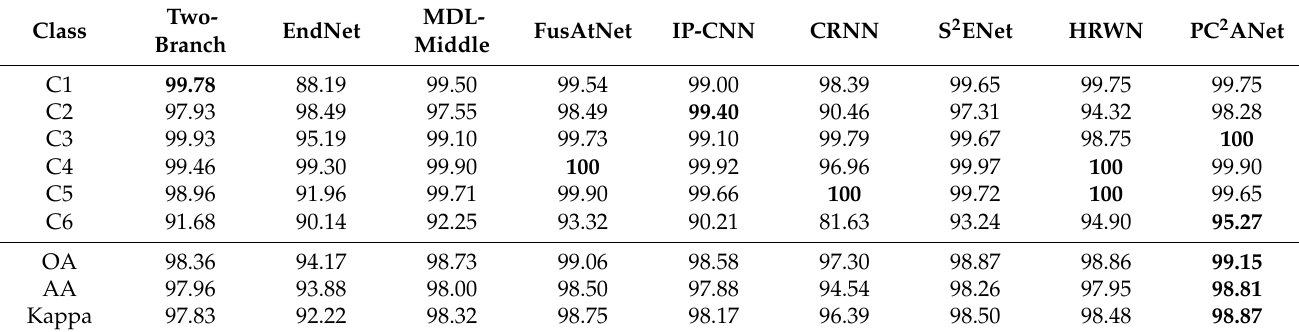
Table 5. Classification accuracies (%) and kappa coefficients of different model on the Trento